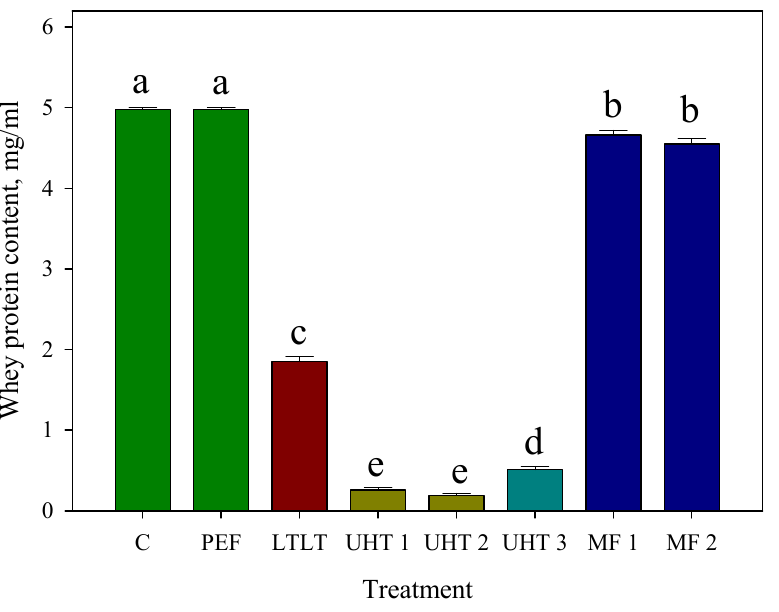
Figure 5. Undenatured whey protein content in milk samples treated with different pasteurization techniques: C—control (raw milk); PEF—pulsed electric field; LTLT—low-temperature long-time; UHT1—ultra-high temperature; UHT2—ultra-high temperature; UHT3—ultra-high temperature; MF1—microfiltration; MF2—microfiltration. Different lowercase letters indicate significant differences between the samples ( p < 0.05).